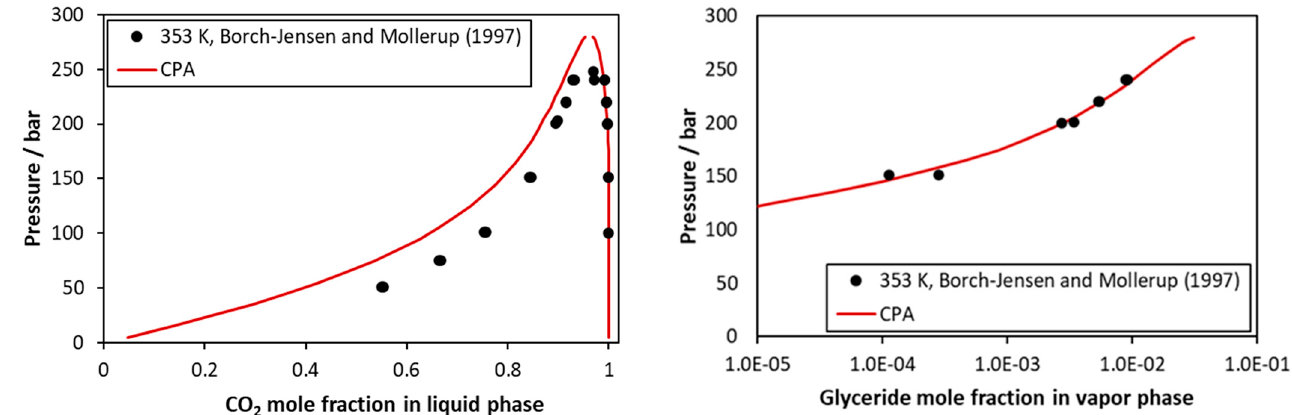
Figure 4. CO 2 –tricaprilyn VLE at 353 K. Experimental data [43] and CPA correlations using the binary interaction parameter of Table 5.